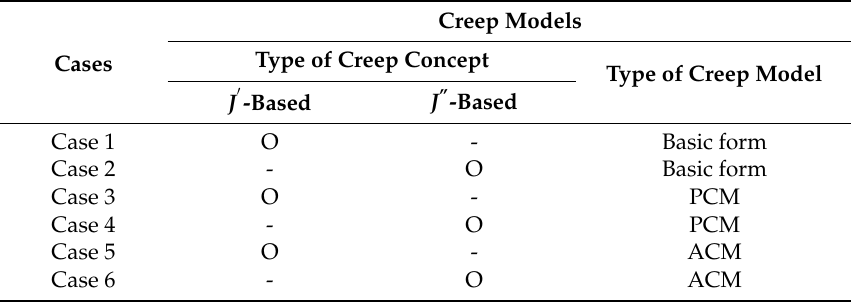
Table 1. Six cases of creep models.